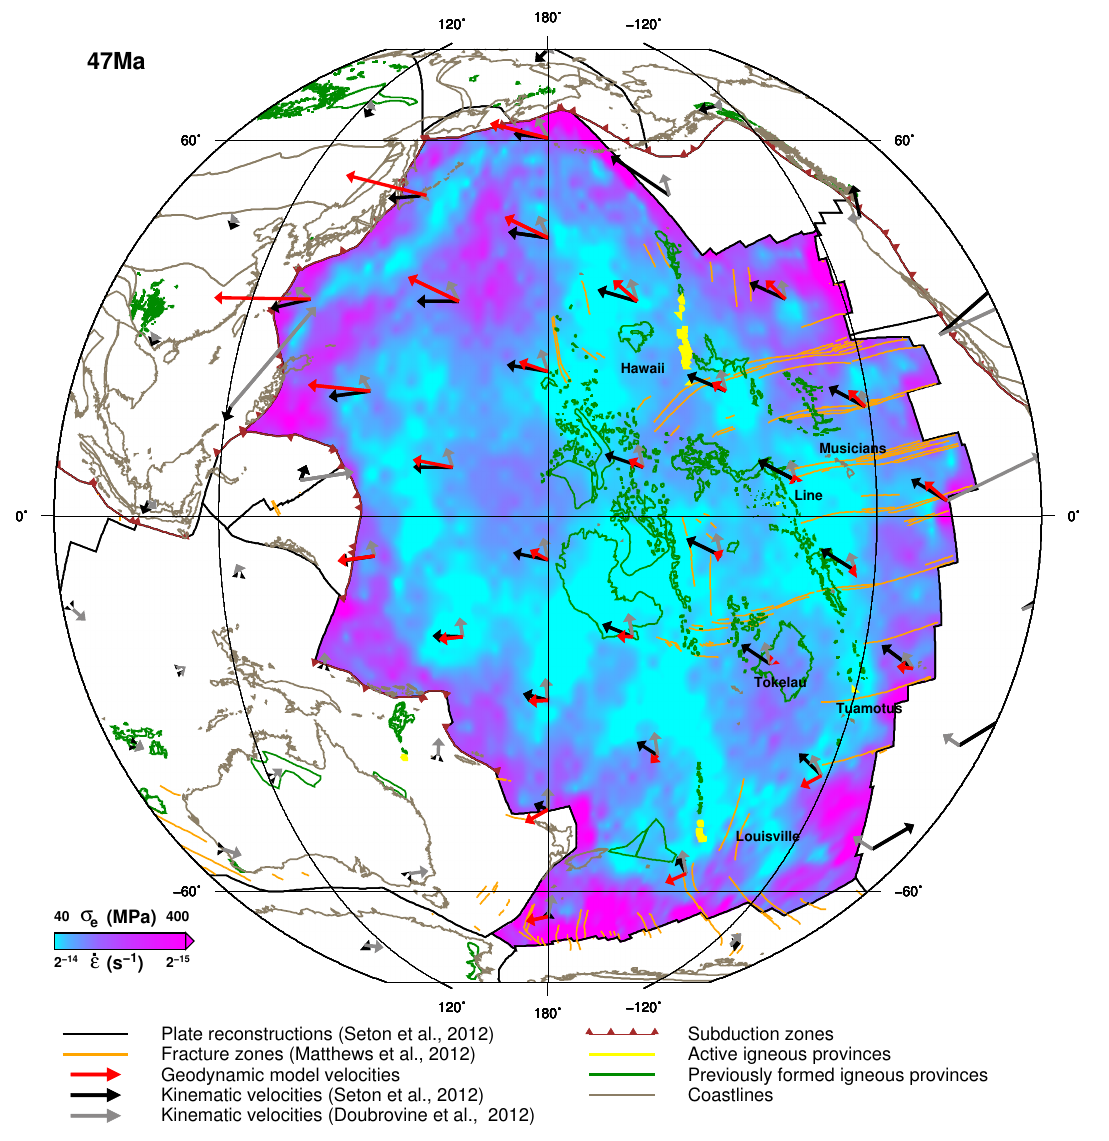
Figure 4. As Fig. 2 but for the Pacific plate reconstruction and model output at 47Ma.